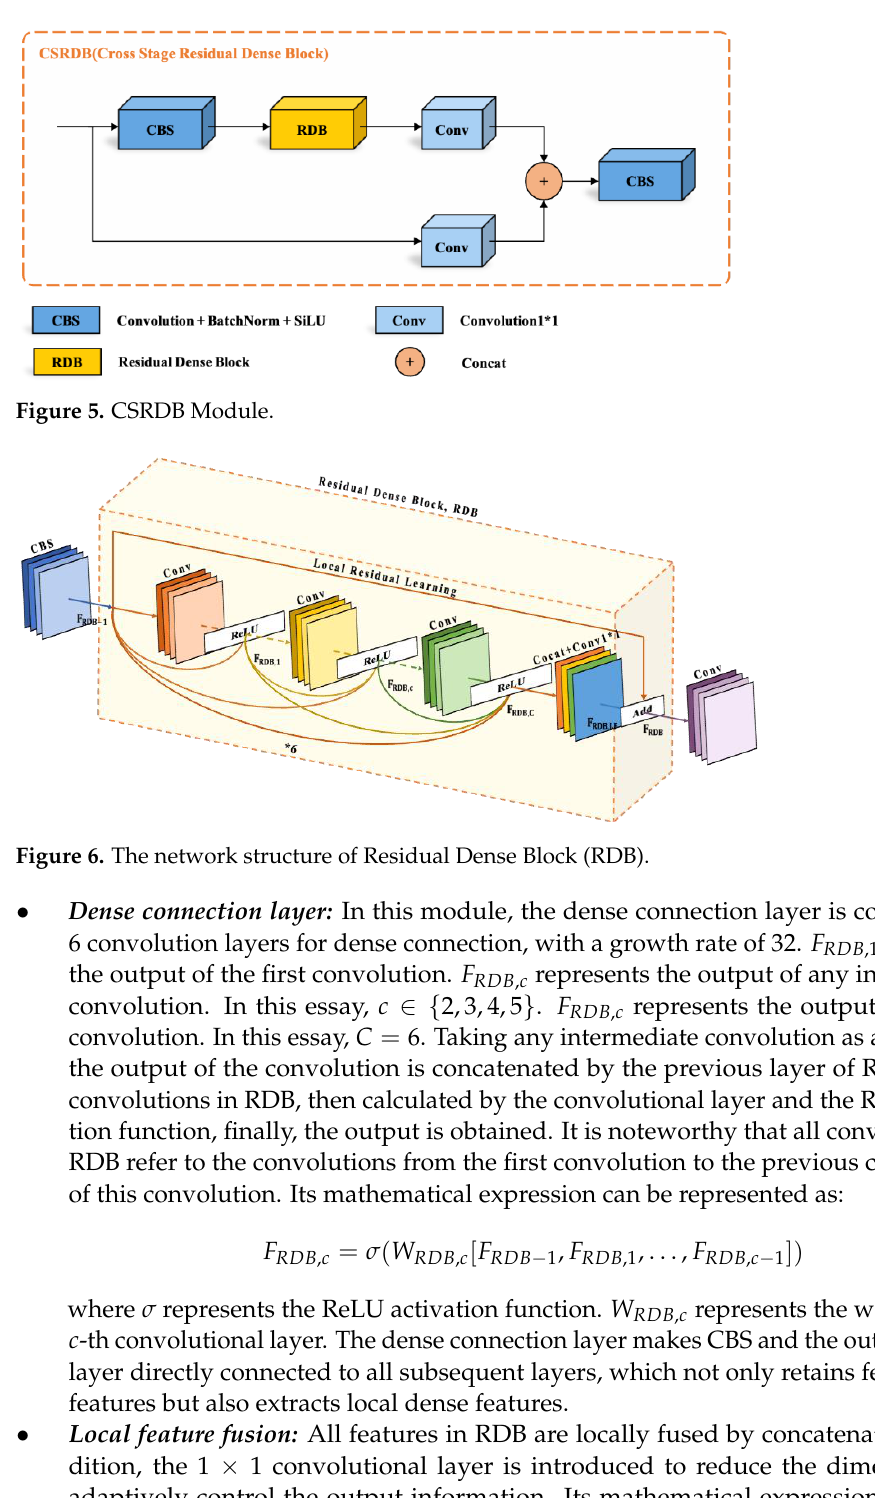
Figure 5. CSRDB Module.